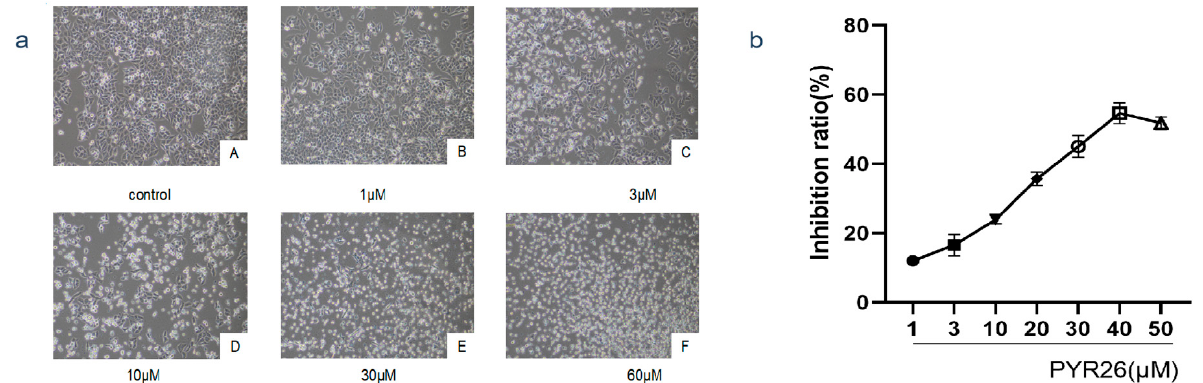
Figure 1. ( a ) Effect of PYR26 on amount of HepG2 cells ( × 100). The cultures were grown for 24 h, Figure 1. ( a ) E ff ect of PYR26 on amount of HepG2 cells (×100). The cultures were grown for 24 h, and the medium was changed to that containing various concentrations of PYR26 ( fi nal concentra- tion: ( A ) control, ( B )1 µ Μ , ( C ) 3 µ Μ , ( D ) 10 µ Μ ( E ) 30 µ Μ and ( F ) 60 µ Μ ) for another 24 h. ( b ) Cell